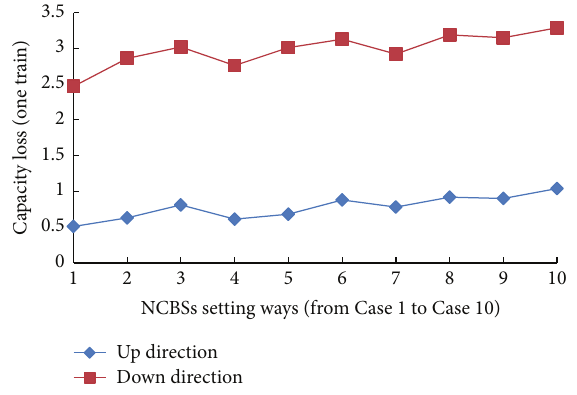
Figure 22: Capacity loss caused by different NCBSs setting